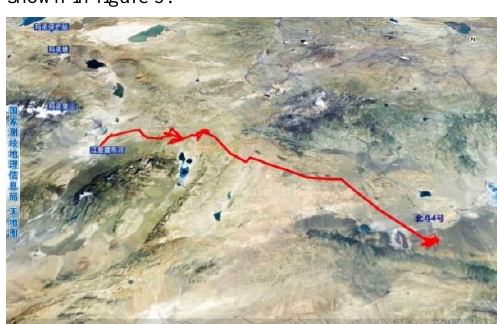
Figure 3: Migratory path of Tibetan